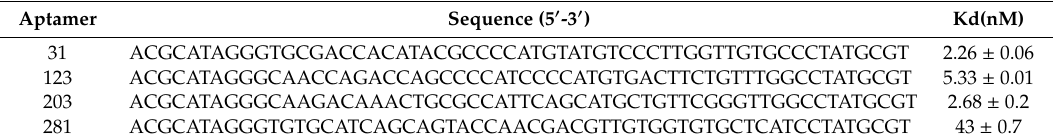
Table 1. Sequence (5 (cid:48) -3 (cid:48) ) and dissociation constant (Kd) of aptamer candidates.